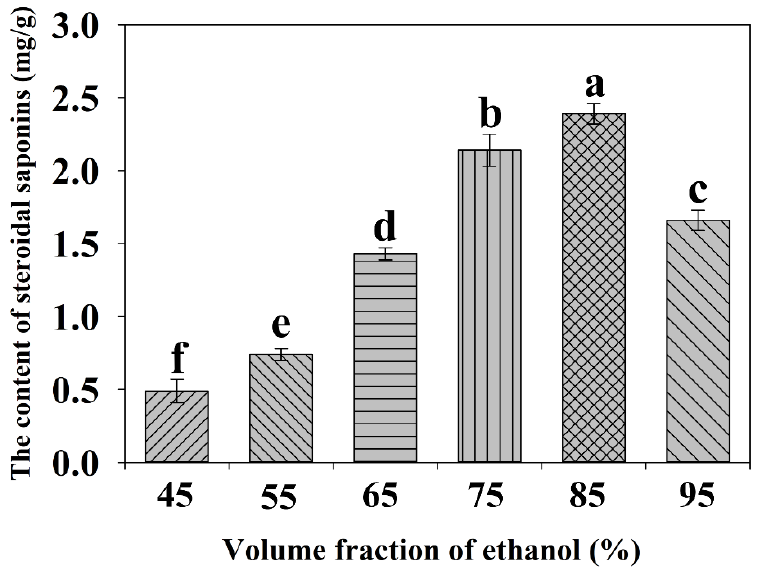
Figure 3. Effect of volume fraction of ethanol on the yield of total steroidal saponins. Different lowercase letters represent the difference among treatments of volume fraction of ethanol, p ≤ 0.05. Error bars indicate mean values ± SD, ( n = 3).